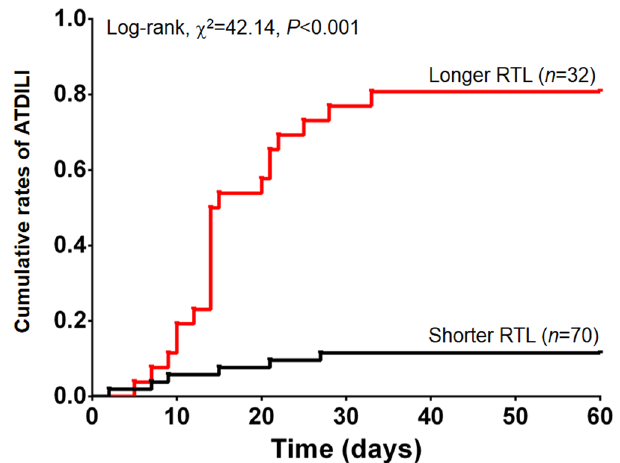
Figure 2. Kaplan-Meier curve for occurrence of ATDILI. Kaplan-Meier curve represents cumulative rates of ATDILI between tuberculosis patients with longer RTL and shorter RTL. Abbreviations: ATDILI, anti- tuberculosis drug-induced liver injury; RTL, relative telomere